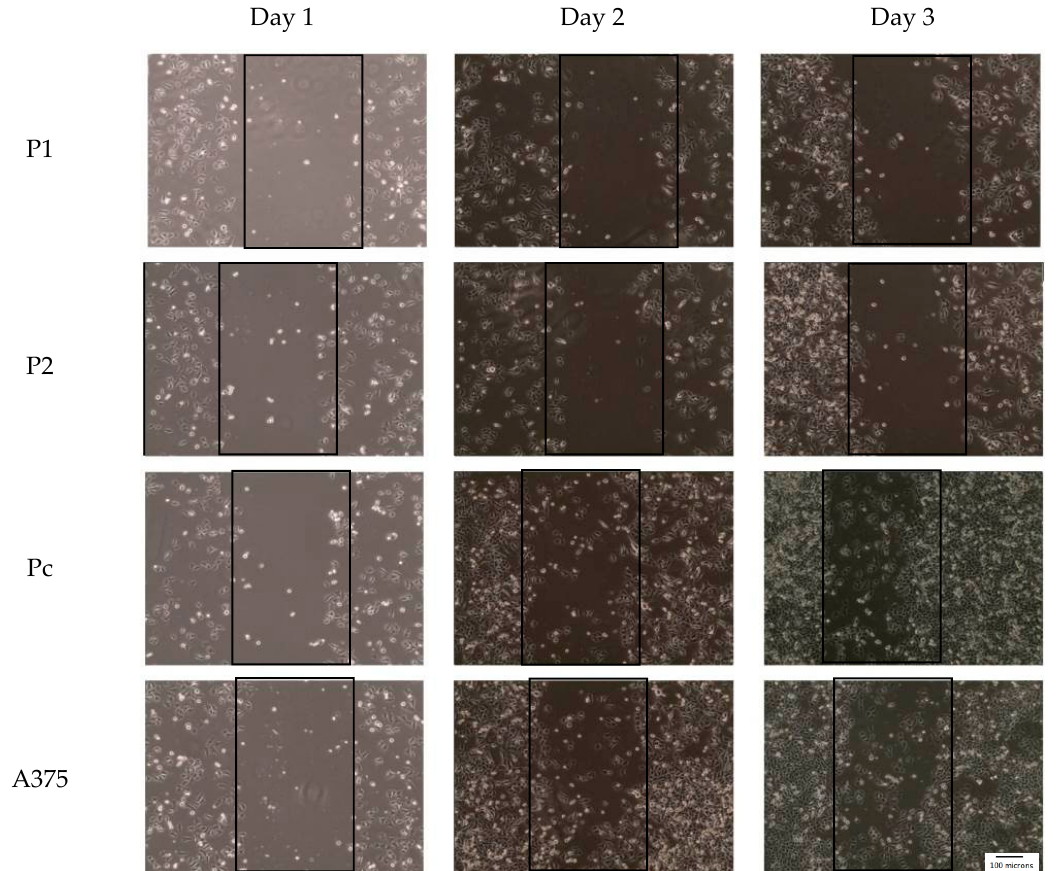
Figure 6. Effect of YB-1 shRNA on cancer cell migration (wound closure assay): cells were visualized with 10× magnification power under a light microscope. The wounds were monitored every 24 h for three days to determine the rate of closure by the migratory cancer cells.